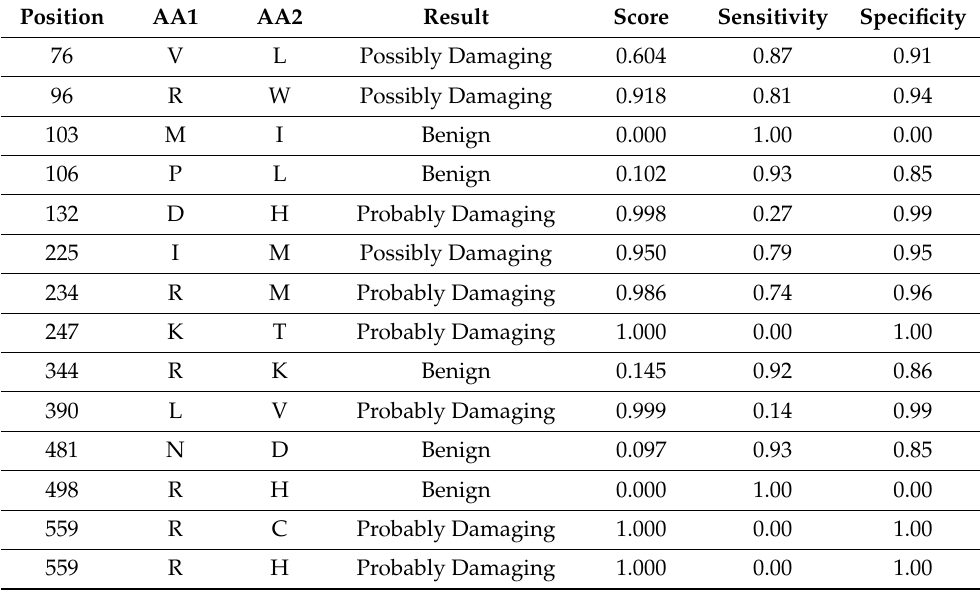
Table 1. The prediction of functional changes in NEIL3 with certain site mutations. Position AA1 AA2